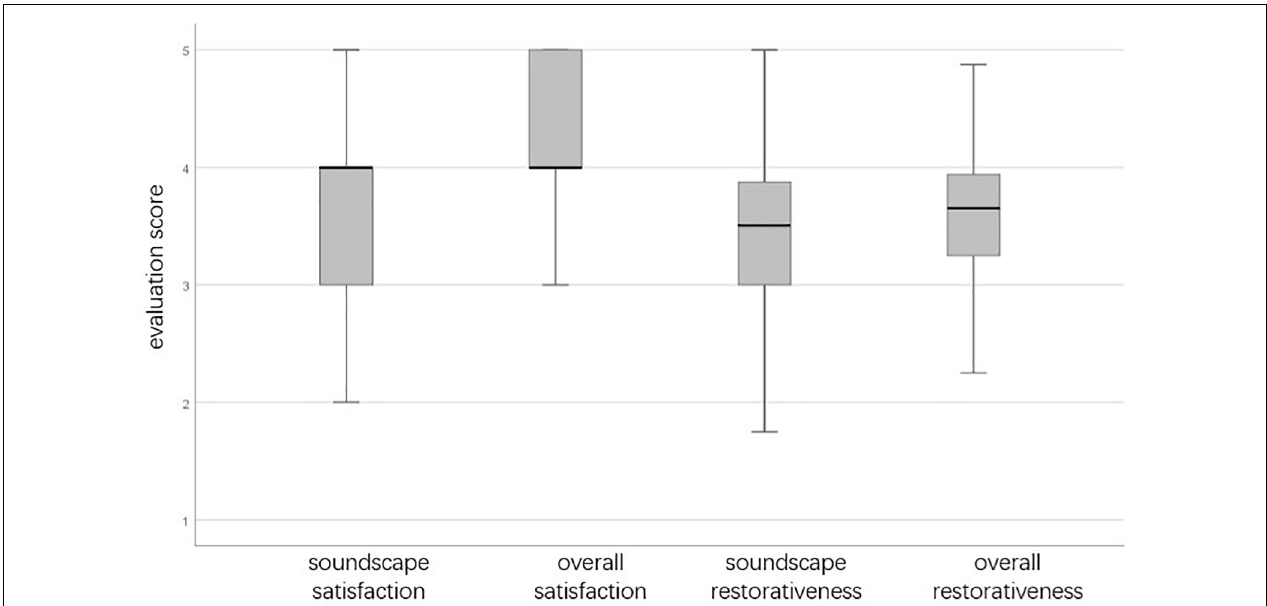
FIGURE 2 | The evaluation score of satisfaction and restorativeness on a five-point scale. Box lines represent extremum and quantile, and the black bold line represents the median.